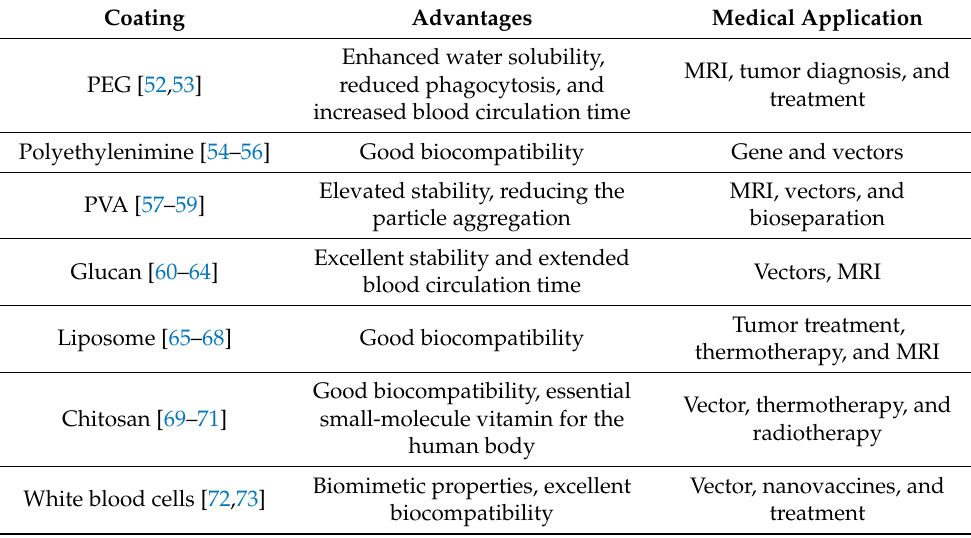
Table 1. Coatings of NPs with possible medical